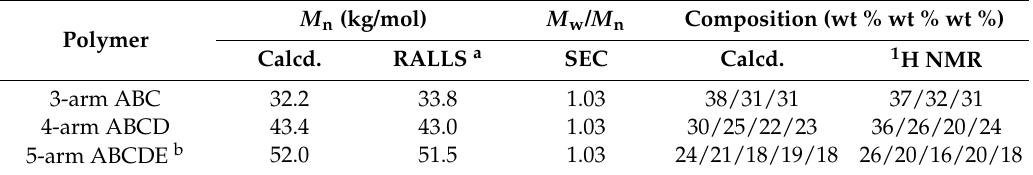
Table 2. Characterization results of ( µ -SP)s synthesized by the iterative methodology using X 1 and X 2